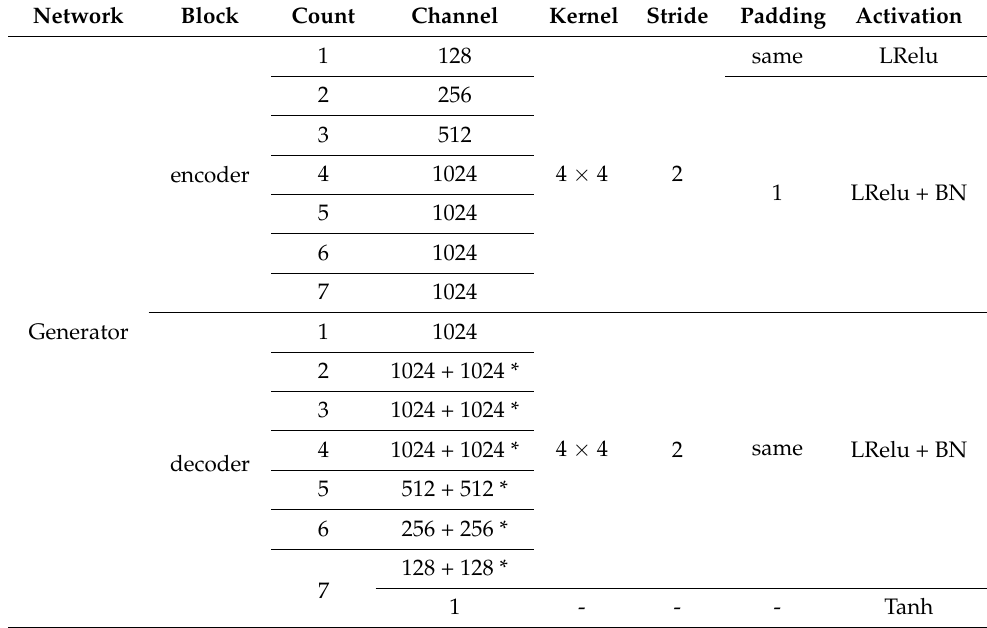
Table A2. Pix2pix.